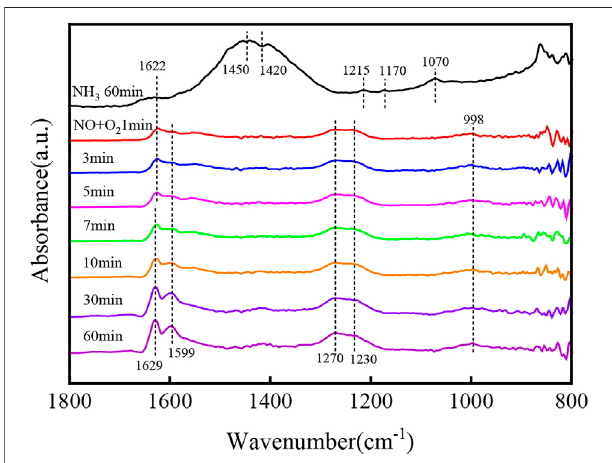
FIGURE9| Insitu DRIFTspectraofNO+O 2 reactionwithpre-adsorbed NH 3 over the Mn 6 Zr 0.3 Co 0.7 catalyst at 200 ° C.